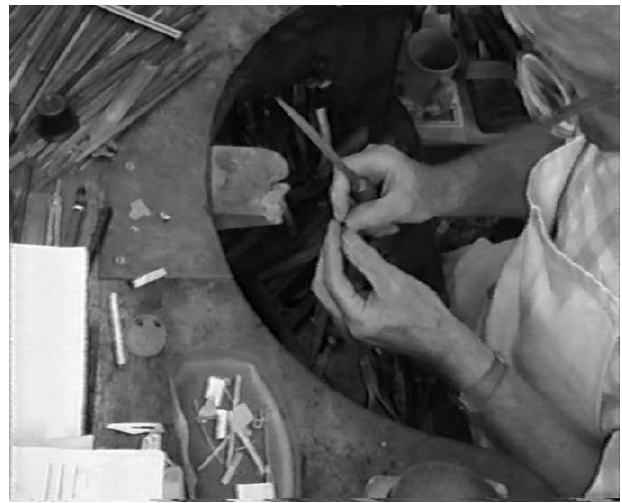
Figure 3. A jewellery maker filing a gold